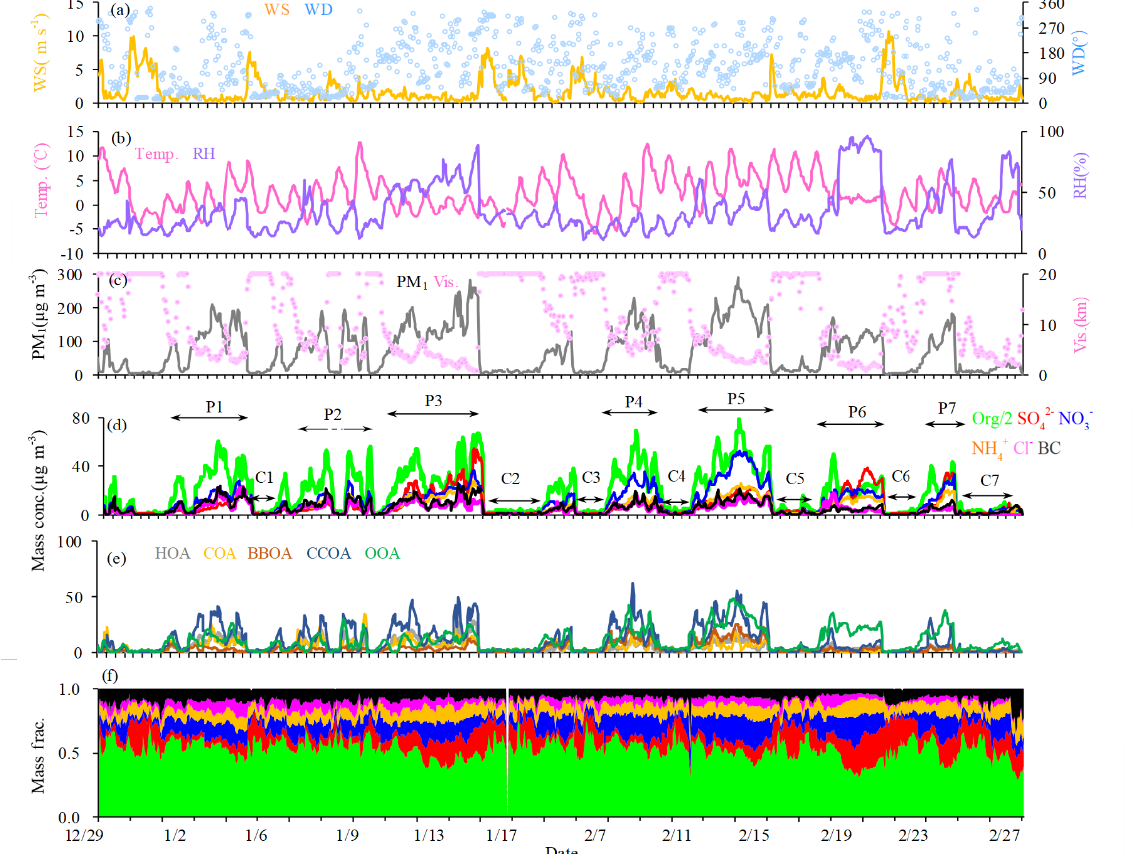
Figure 1. Time series of (a) wind speed (WS) and wind direction (WD), (b) temperature (Temp) and relative humidity (RH), (c) visibility and PM 1 , (d) NR-PM 1 species (i.e., OA, SO 2 − measured), (e) OA factors (i.e., HOA, COA, BBOA, CCOA and OOA), and (f) relative contribution of PM 1